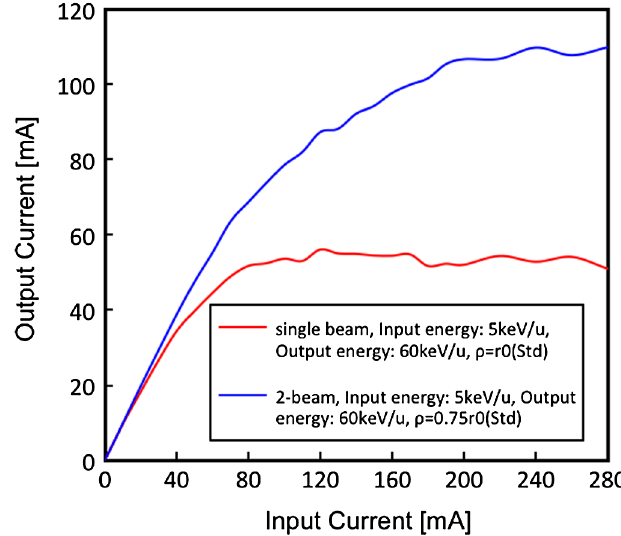
FIG. 16. Output current as a function of the input current in a single and two-beam RFQ linac. The Kilpatrick factors of the single and two-beam linac are 3 and 1.8, respectively.